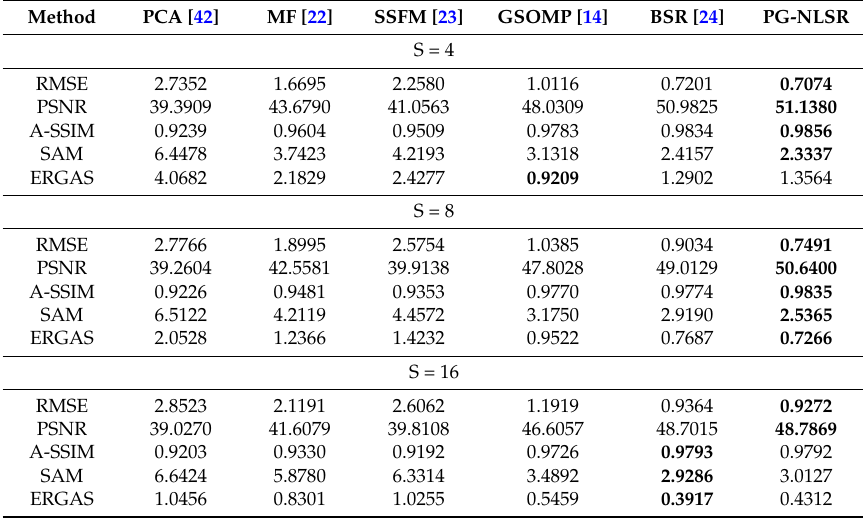
Table 2. Evaluation assessments for Pavia Centre HSI over different scale factors.